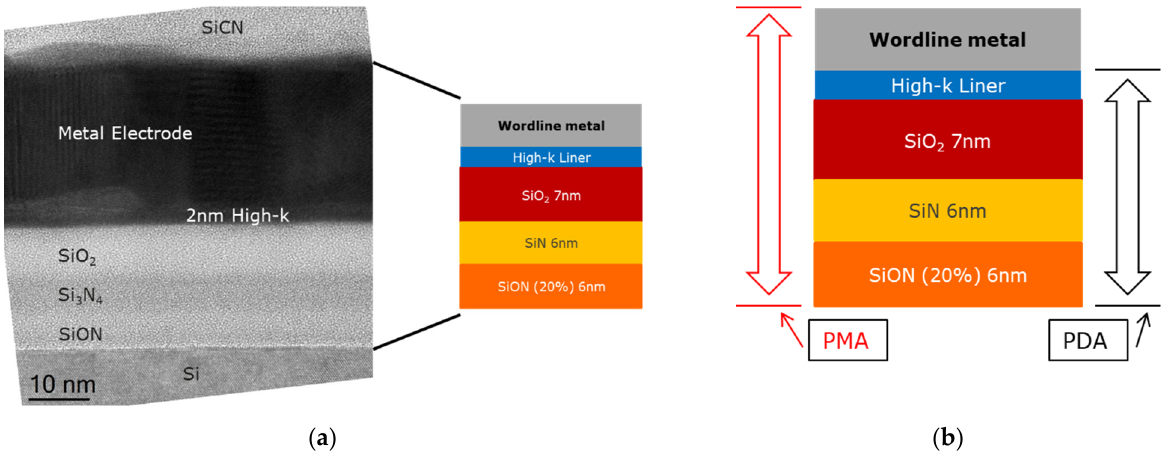
Figure 9. ( a ) Transmission electron microscope (TEM) image of a memory stack fabricated in this work; ( b ) different anneal types and the corresponding MHONOS layers that received the anneal.